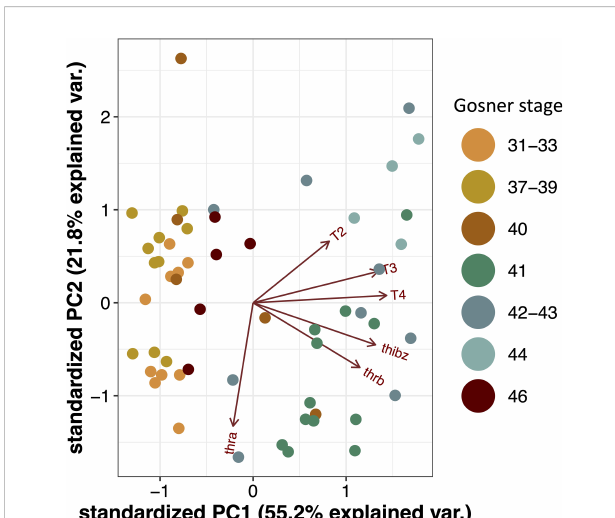
FIGURE 2 Principal component analysis (PCA) biplot for T4, T3, and T2 concentrations and gene transcript abundance of thra, thrb and thibz. Dots represents samples from individuals and colors represents Gosner